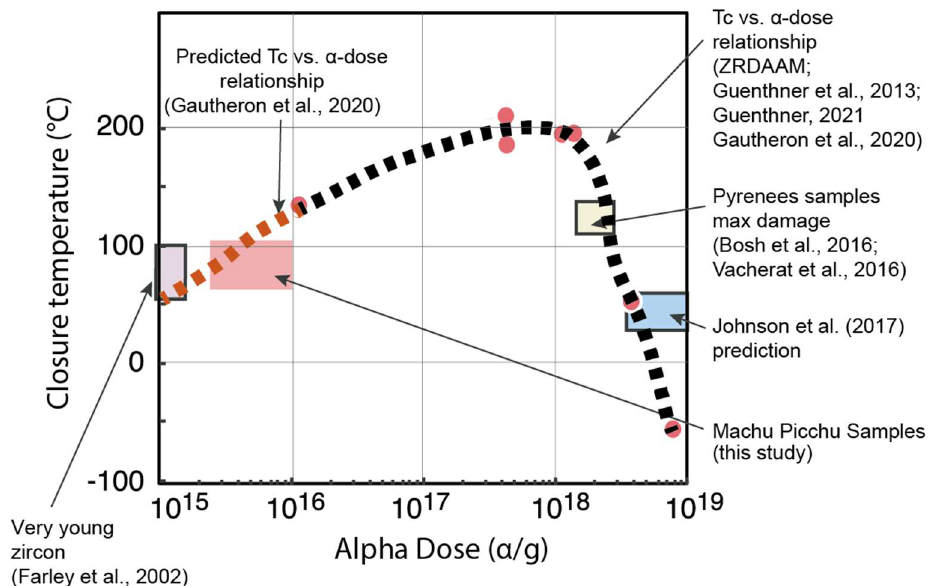
Figure 8. Update of the coevolution of the closure temperature and the α -dose from [18] with our new data from the Machu Picchu profile (red square). Red circles correspond to [15] data recalculated with the density functional theory results (see details in [18]), the yellow box places Pyrenean samples [52,53], and the blue box represents [10] highly damaged zircons. The black dashed line shows the shape of the closure-temperature/ α -dose relationship presented in previous models. We added an estimation of the closure-temperature/ α -dose relationship inferred from [18] (red dashed line), and the estimated closure temperature of the ZHe from Machu Picchu (this study, red